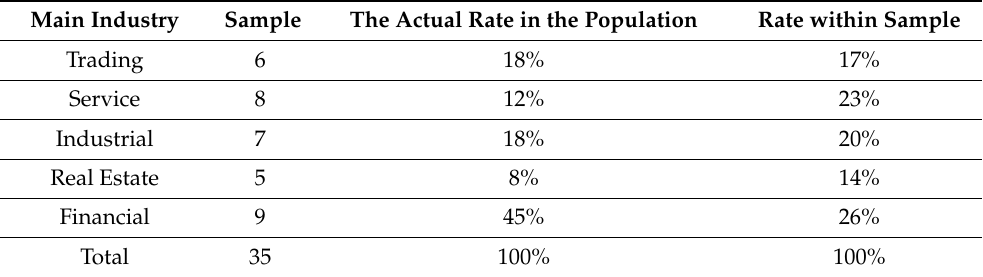
Table 2. Stratified random